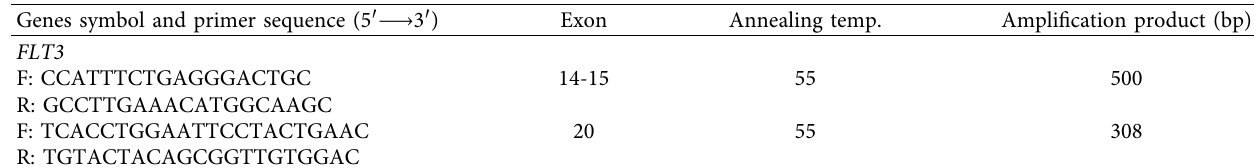
Table 1: Forward (F) and reverse (R) primer sequences for polymerase chain reaction with corresponding annealing temperature and their amplification products used to investigate mutations. Genes symbol and primer sequence (5 ′⟶ 3 ′